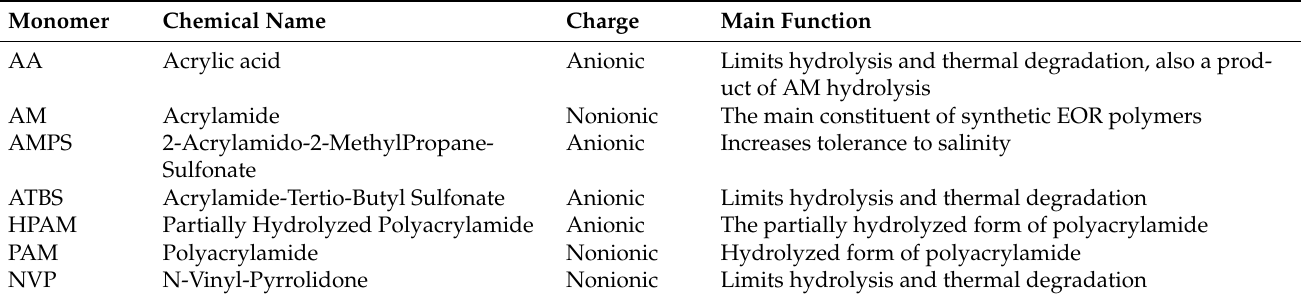
Table 3. Chemistry of different monomers used to functionalize acrylamide for sustaining harsh conditions [8].